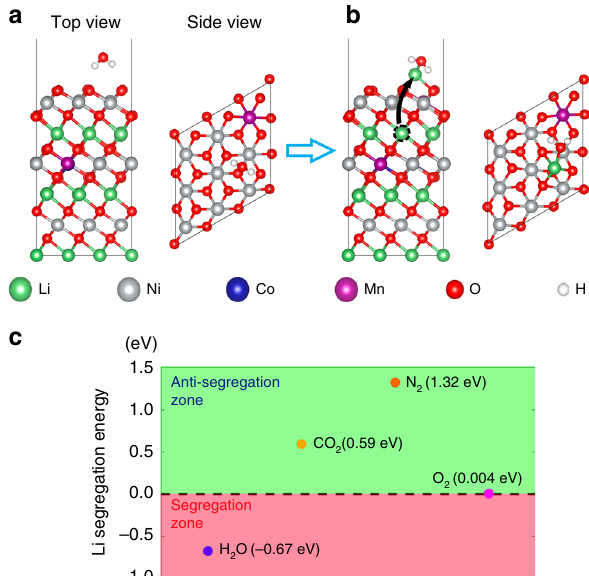
Fig. 6 Li segregation energies under the adsorption of air components. a , b The atomic structures of conventional NMC, and delithiated NMC with a Li ion moves from the subsurface to the surface 3b sites under gas molecule adsorption. The dashed black ring indicates the migrated Li ions and the black arrow points to the surface site that the sub-surface Li migrates to. c The plot of Li segregation energies under the water vapor, O 2 , CO 2 , and N 2 adsorption. The upper and lower regime represent the Li anti-segregation, and segregation zone,